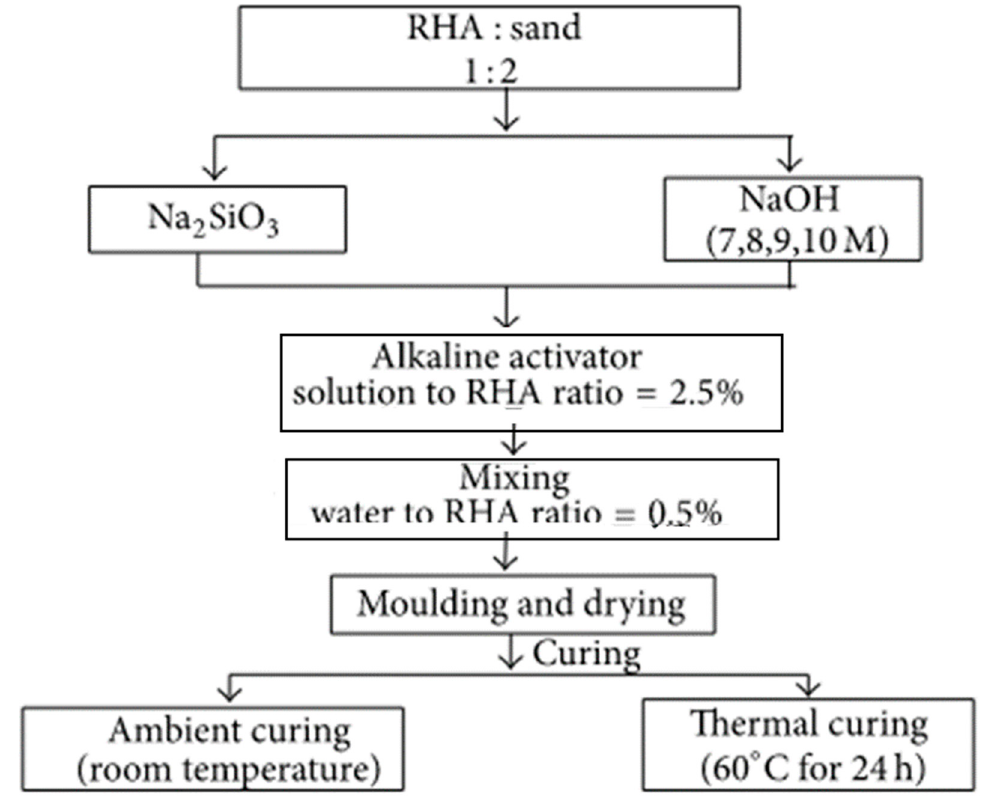
Table 3. Factors to be considered in mix design of different studies.